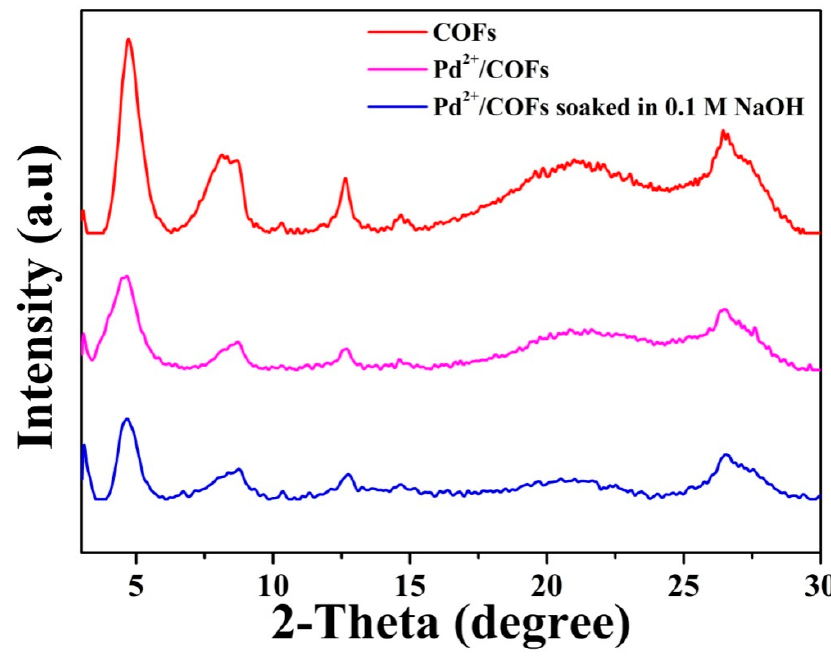
Figure 3. XRD patterns of COFs, Pd 2+ /COFs and Pd 2+ /COFs soaked in 0.1 M NaOH for 24 h.